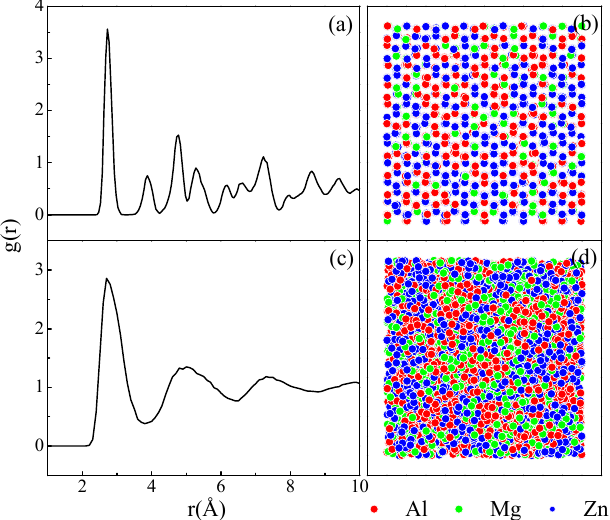
Figure 2. The atomic position projections and the total pair-correlation functions, g ( r ) , ( a , b ) the crystalline structure (Al 40 Mg 15 Zn 45 ); ( c , d ), the amorphous phase (Al 40 Mg 25 Zn 35 ). Red, green, and blue circles represent Al, Mg, and Zn atoms, respectively.